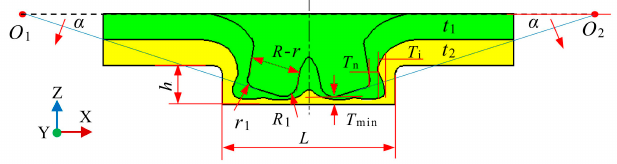
Figure 6. Main parameters of the joint.